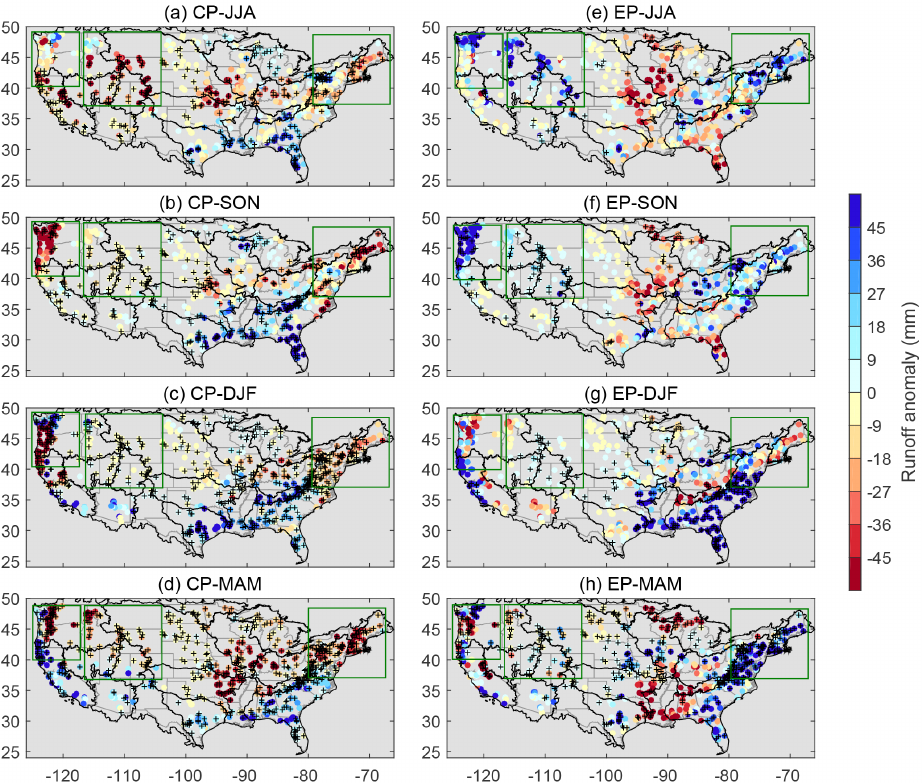
Figure 4. Seasonal composite of runoff anomaly (unit: mm) for the two types of El Niño on (a) JJA, (b) SON, (c) DJF, and (d) MAM in CP-El Niño years during the period of 1990-2009; (e–h) the same as (a–d) , but for EP-El Niño years. + indicates results at 0.05 significance level based on a Monte Carlo test.